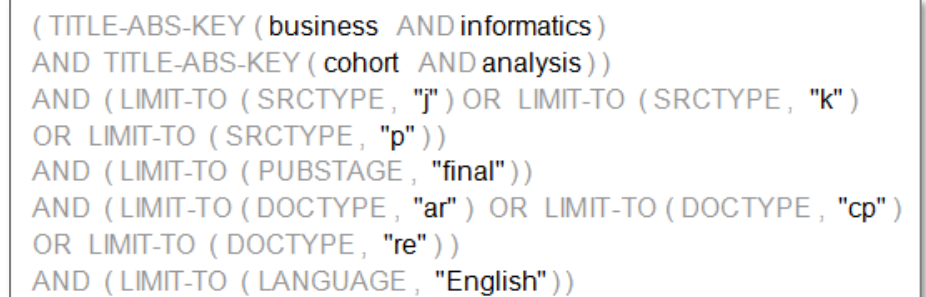
Figure 3. The search query for the scientific papers in the Scopus database.